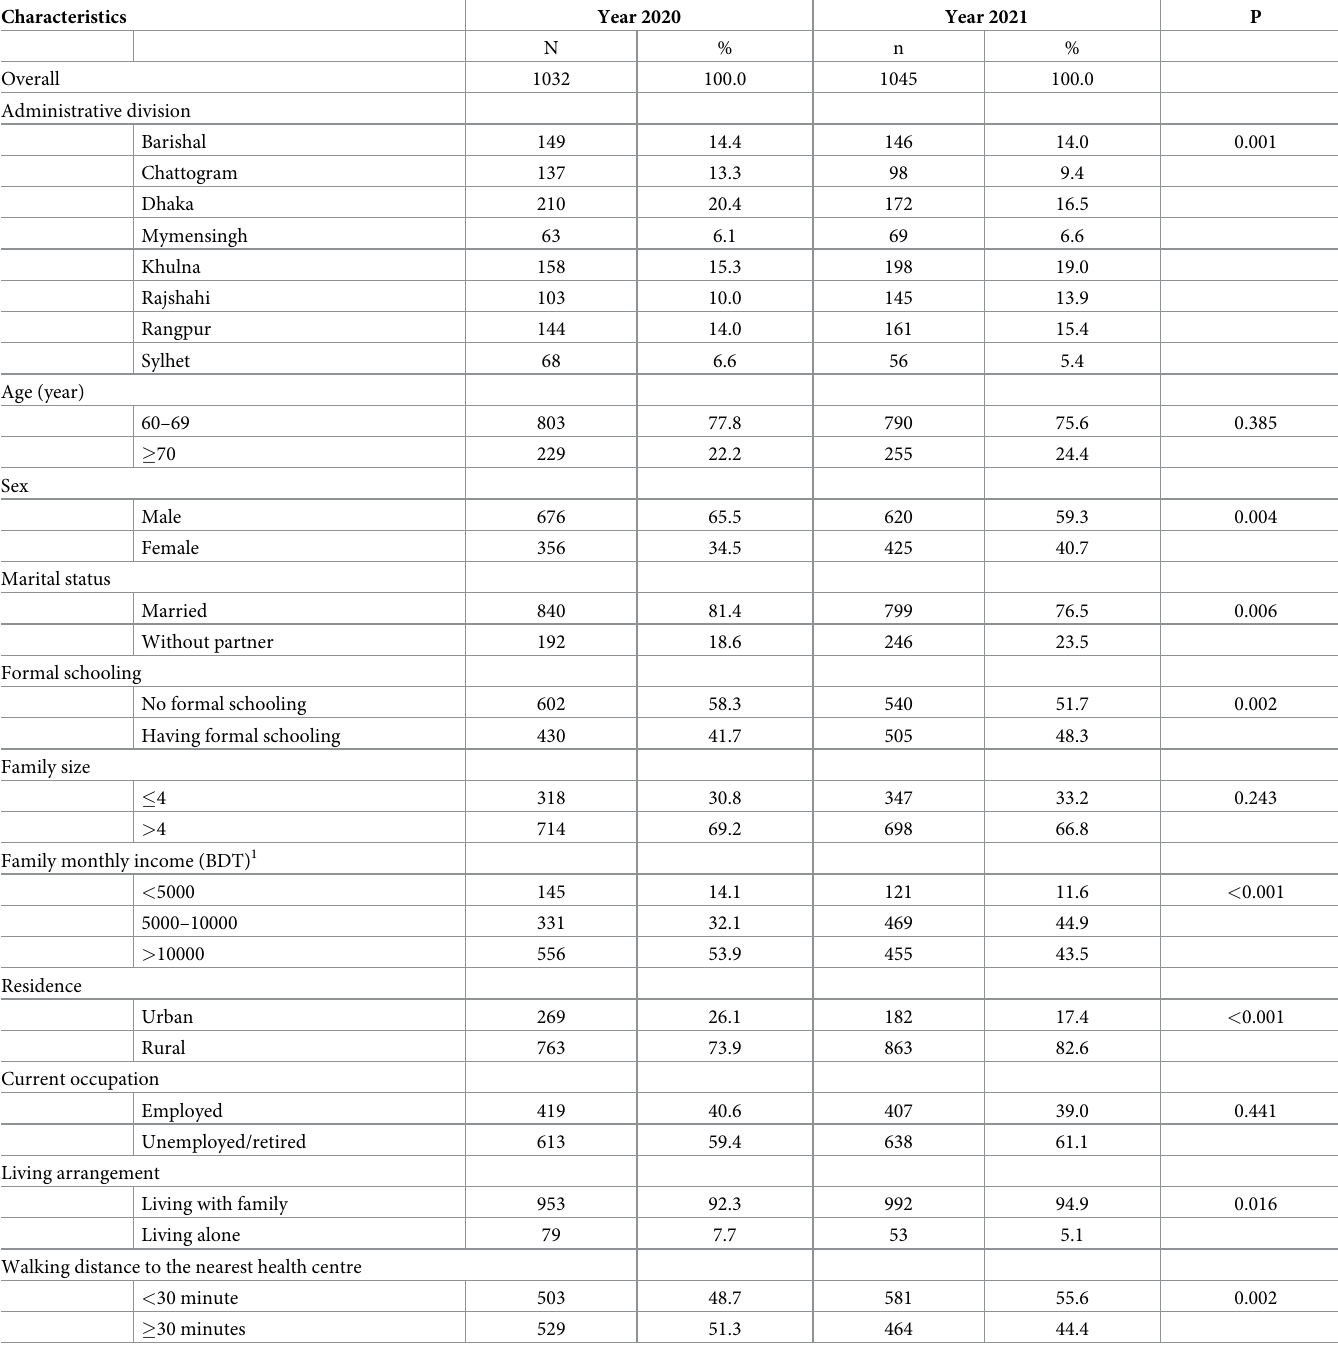
Table 1. Characteristics of the participants (n = 2077).